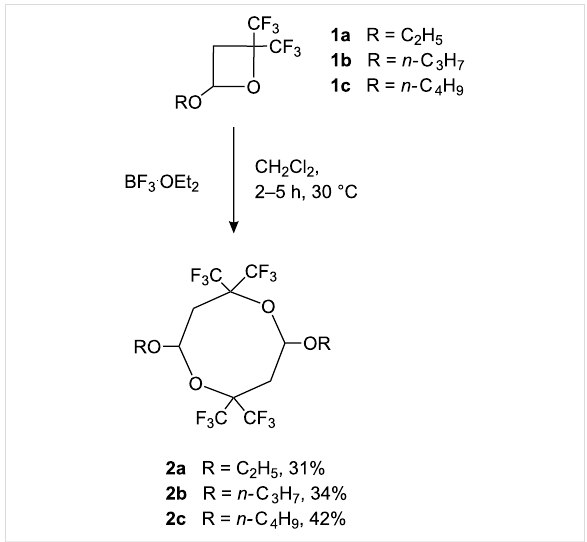
(Scheme 1 and Figure 1 for structure of 2a and 2b , Supporting Information File 2 for single crystal X-ray